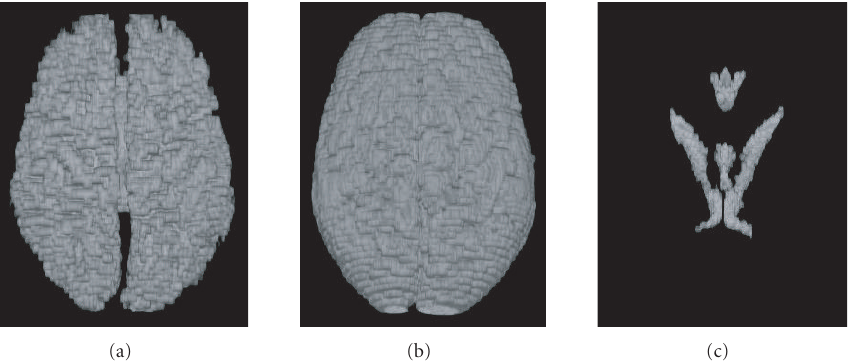
Figure 7: Segmentation of one MRI data set. Three-dimensional rendering of segmented volumes for (a) WM, (b) GM, and (c) CSF.